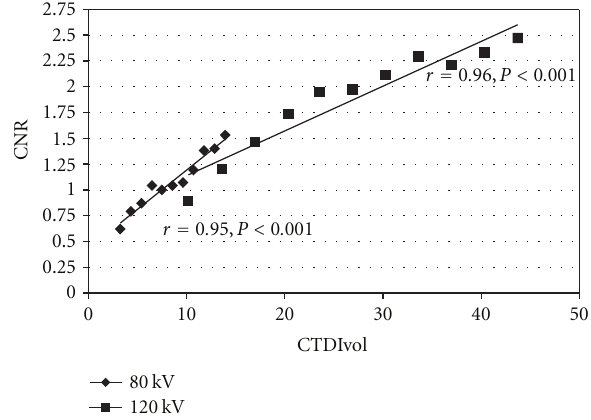
80kV 120kV Figure 3: Graph shows relationship between CTDIvol and CNR. The Pearson correlation coe ffi cient ( r ) and the corresponding P values were r = 0 . 95 and P < 0 . 001 at 80 kV and r = 0 . 96 and P < 0 . 001 at 120 kV.